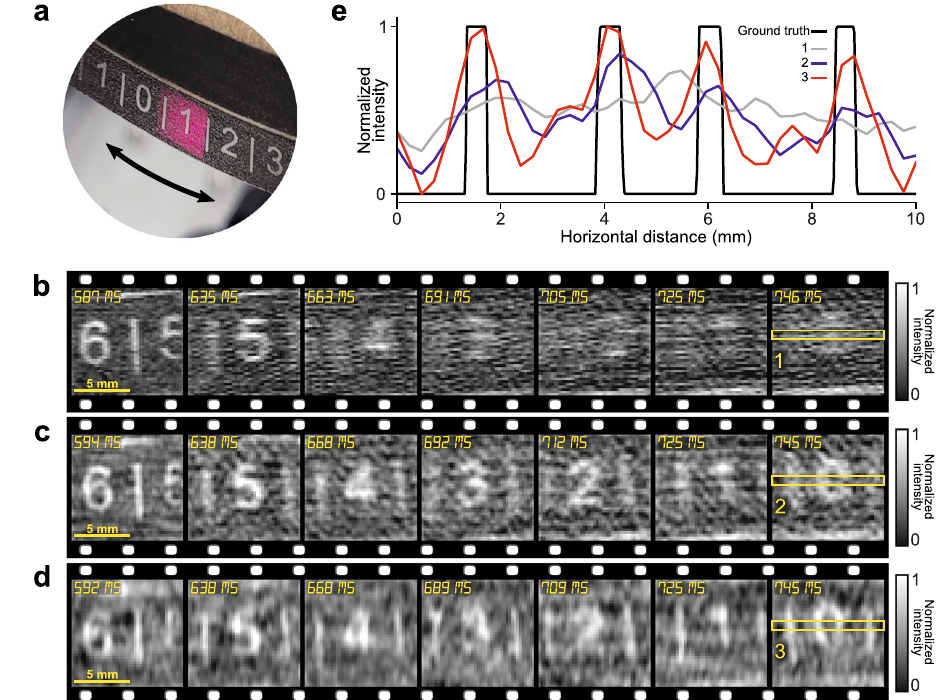
Fig. 3 | SPI-ASAP of motion of a transmissive position ruler attached to a pendulum.a PhotographofpositionrulerandilluminatedFOVof10mm×10mm. b – d Selected frames from reconstructions with 100% sampling at145 fps ( b ), 50%-